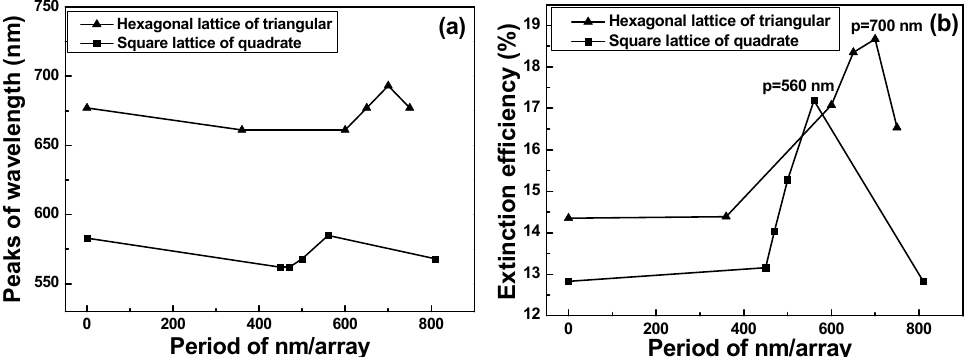
Figure 3. Relationships between: ( a ) the wavelength having the maximum extinction efficiency; and ( b ) the maximum extinction efficiency with the periods of the hybrid Au–Ag nanoparticle arrays as a function of monome shape.